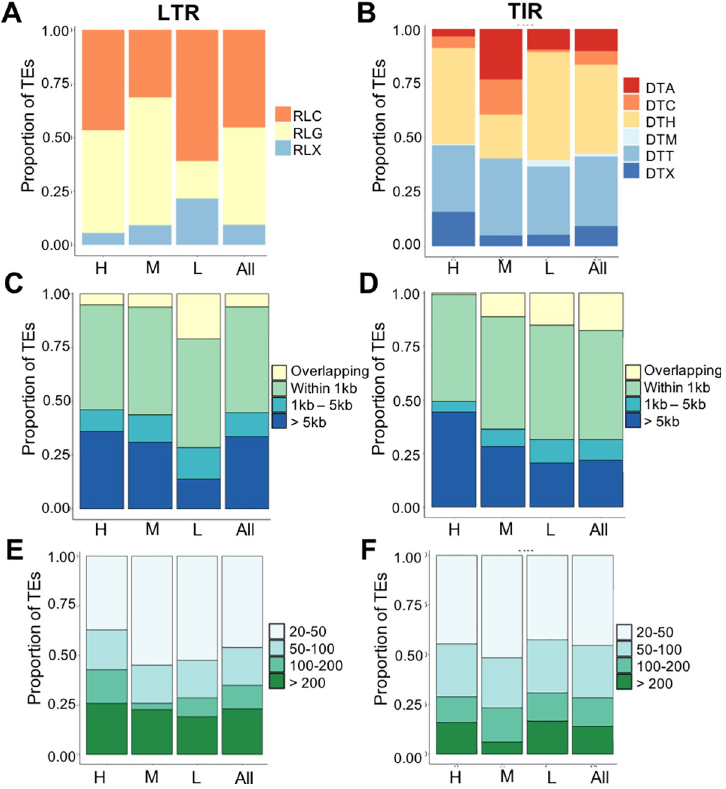
Fig 4. Analysis of attributes for members of TE families of high, moderate and low flanking CG/CHG methylation. (A-B). The proportion of superfamily designations for TEs classified as having high, moderate or low flanking methylation were compared to the proportion for all TE families. LTR elements (A) are classified into copia (RLC), gypsy (RLG) or unclassified (RLX) superfamilies. TIR elements (B) are classified as hAT (DTA), CACTA (DTC), PifHarbinger (DTH), Mutator (DTM), Tc1/Mariner (DTT) or unclassified (DTX). (C-D) For all elements of TE families classified as having high, moderate or low flanking methylation the distance to the nearest gene was determined and binned overlapping, within 1kb, 1-5kb or > 5kb. The proportion of elements with varying proximity to genes was compared for the different clusters of TEs relative to all LTR or TIR elements. (E-F) A similar analysis was done to compare the proportion of families with different copy numbers in each cluster to all LTR (E) or all TIR (F) elements. Family size was classified into 4 groups: 20–50 members, 50–100 members, 100–200 members, and > 200 members from light to dark color